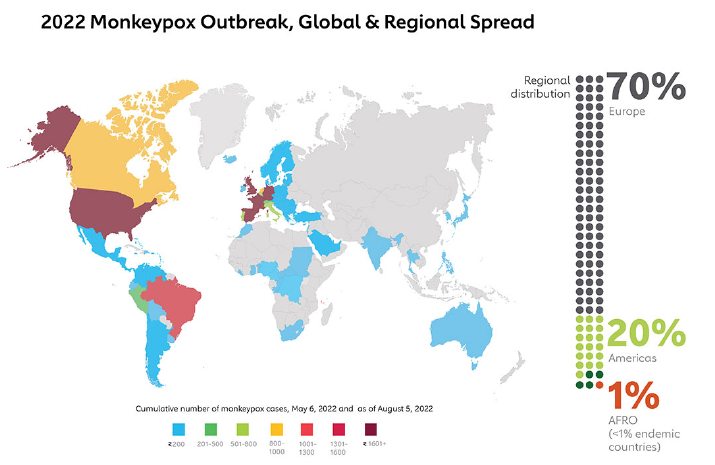
Figure 1. The global and regional outbreaks of